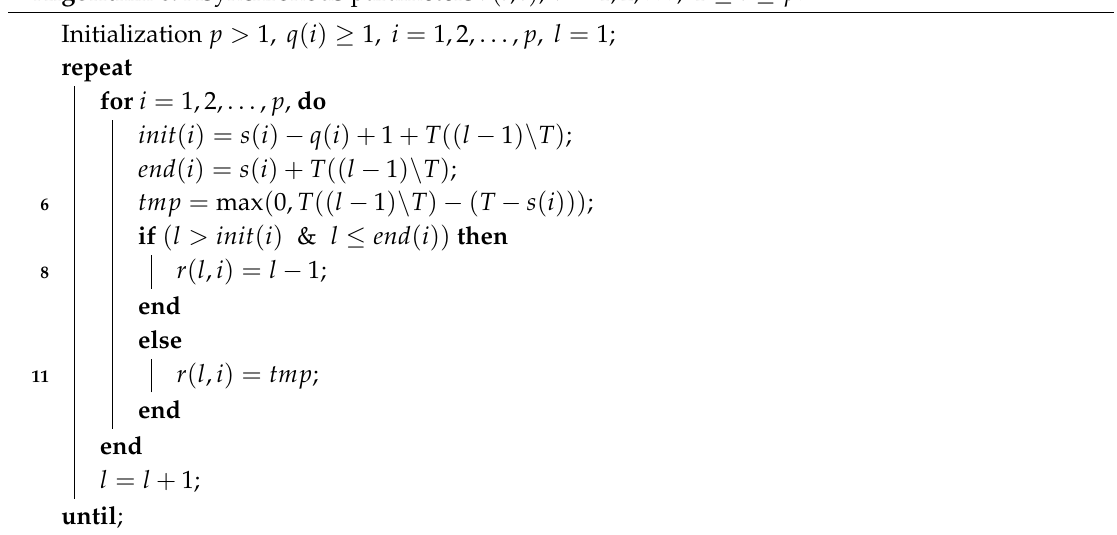
Algorithm 6: Asynchronous parameters r ( l , i ) , l = 1, 2, . . . , 1 ≤ i ≤ p